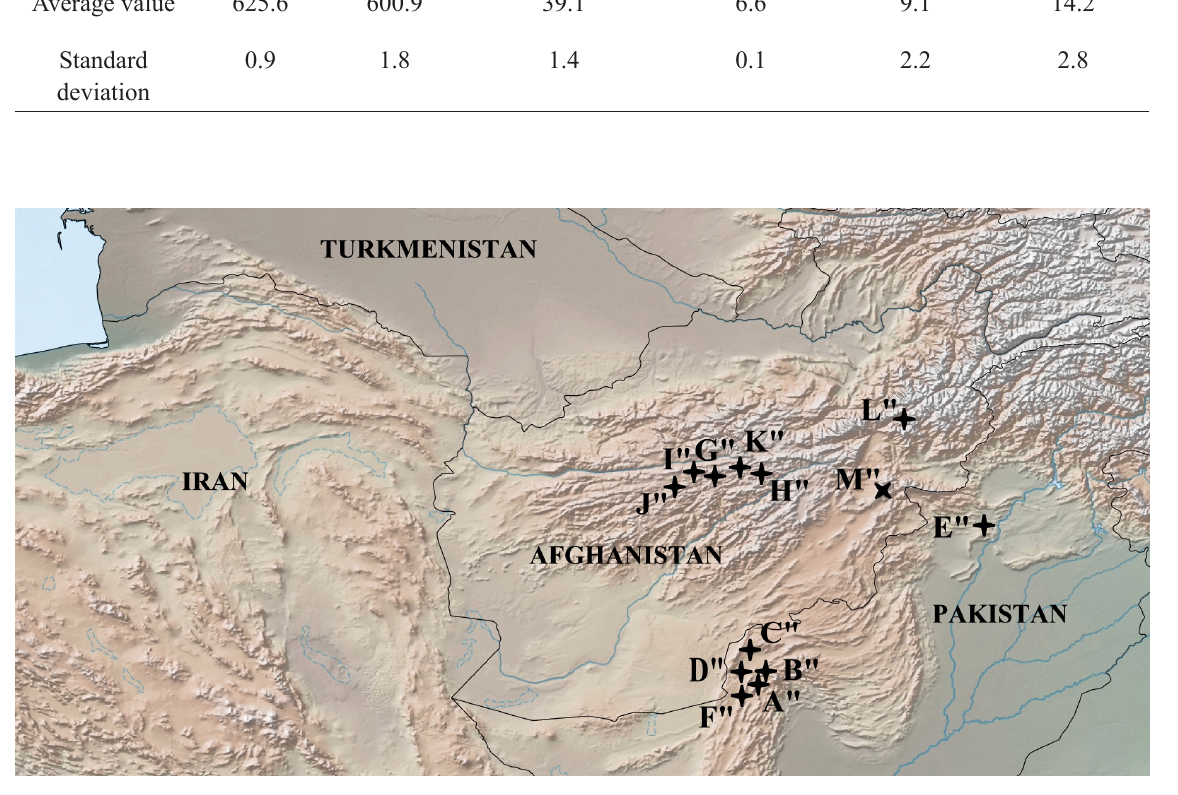
Fig. 8. Distribution of Melitaea mimetica Higgins, 1940 . For a description of the symbols with letters, see Fig.